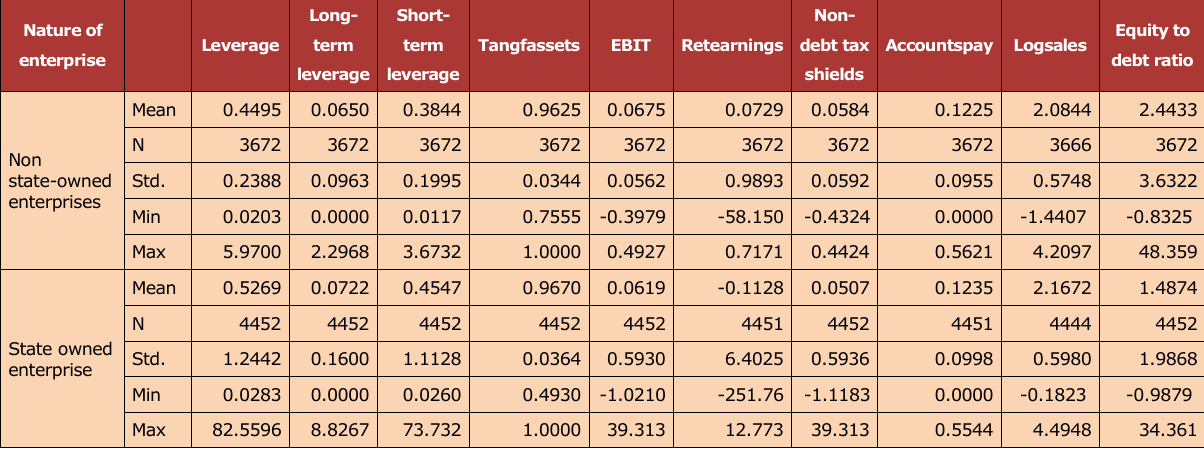
Table 3. The descriptive statistics of the panel data for enterprise's financial indicators in different ownerships (where m is the mass, x is the